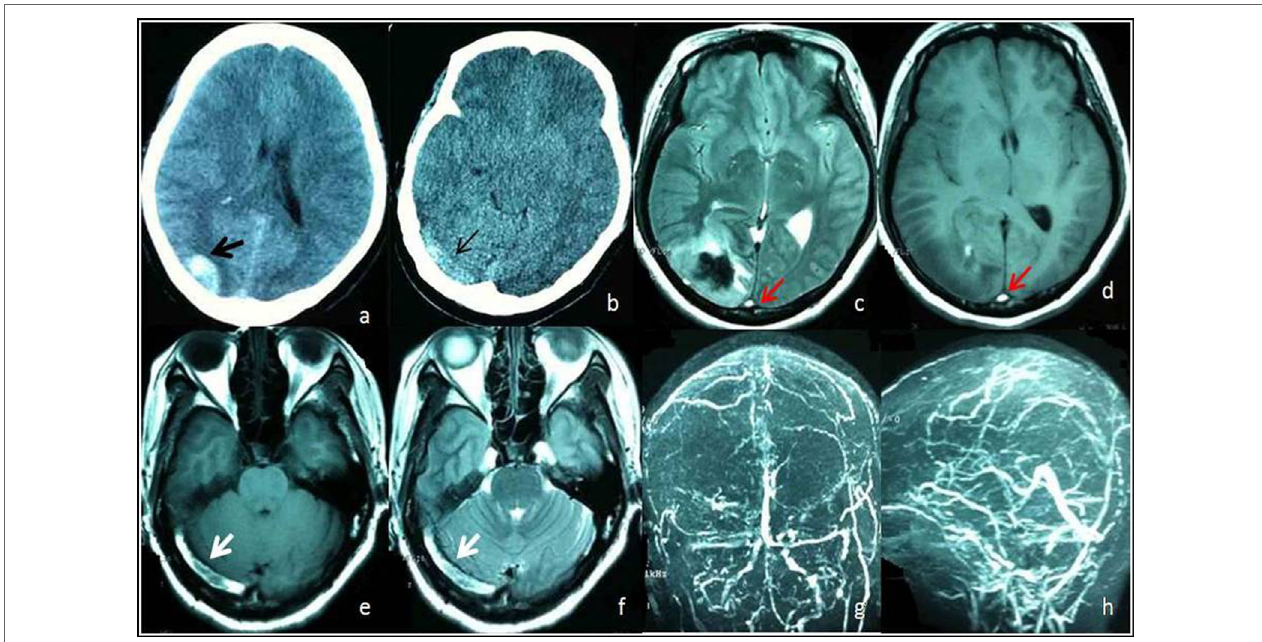
FigUre 3 | A 48-year female admitted to Emergency Room with headache and vomiting. (a) Head computed tomography (CT) shows hemorrhage on right occipital lobe (black arrow). (B) Unenhanced CT image shows areas of abnormal hyperattenuation consistent with thrombus in right transverse sinuses (thin arrow). Axial T1-weighted (D,e) and axial T2-weighted (c,F) MR images acquired 10 days after onset show an area of abnormal increased signal intensity in the superior sagittal sinus (red arrow) and right transverse sinus (white arrow) consistent with subacute thrombi of the superior sagittal sinus and right transverse sinus. Magnetic resonance venography (g,h) shows occlusion of the superior sagittal sinus and filling defects within the right transverse sinus (hollow arrow) due to